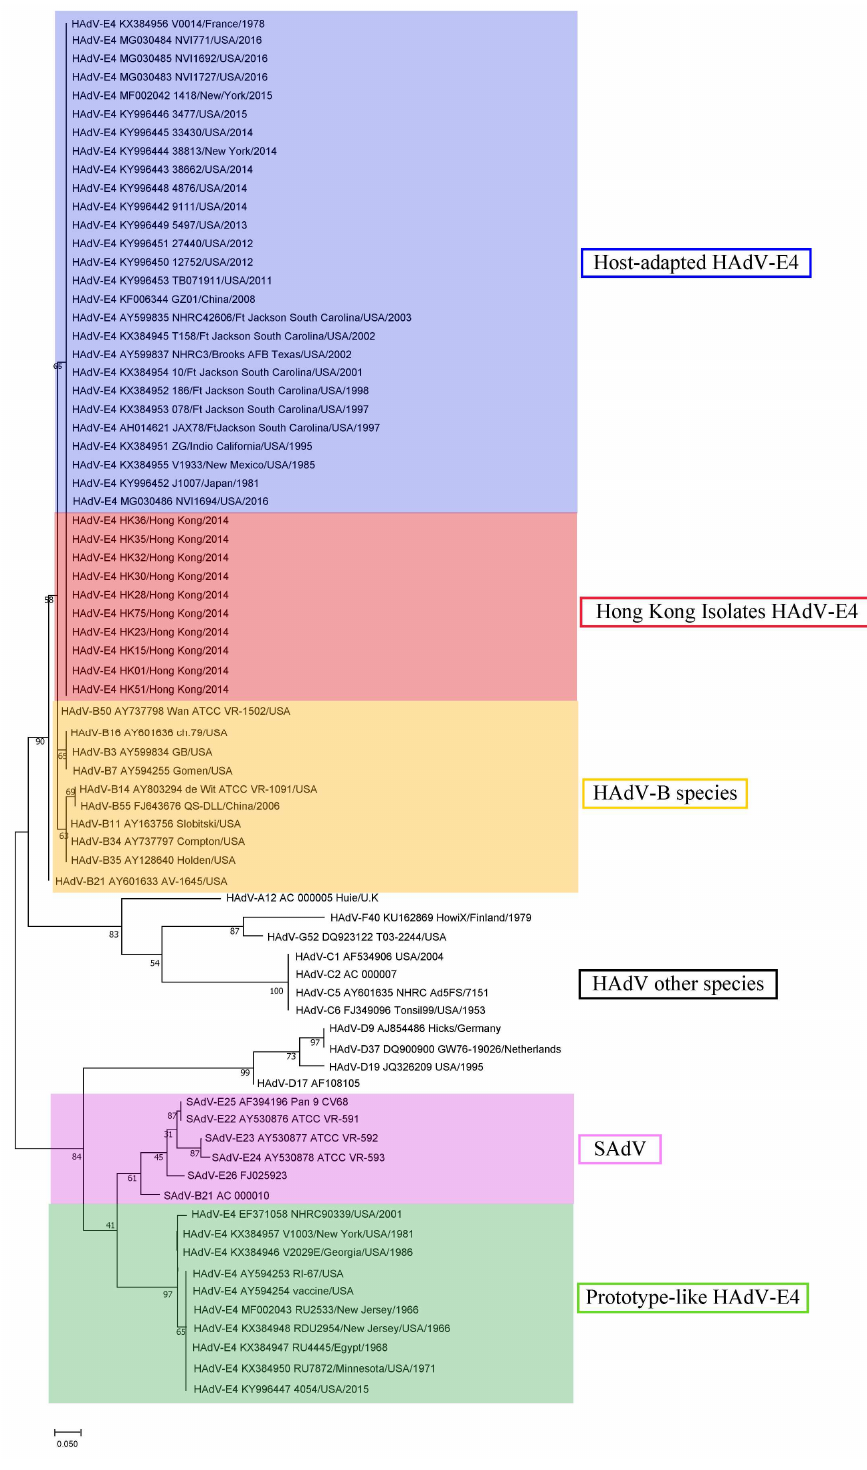
Figure 2. Phylogeny of select HAdV and SAdV ITRs. Recent host-adapted HAdV-E4, including Hong Kong isolates, subclade with HAdVs. Prototype-like HAdV-E4 isolates subclade with SAdVs. Inverted terminal repeats (ca., 116 bases) were aligned using Molecular Evolutionary Genetics Analysis (MEGA) 7.0.26 software (https://www.megasoftware.net), and phylogenetic trees were constructed with a maximum-likelihood method incorporating 1000 bootstrap